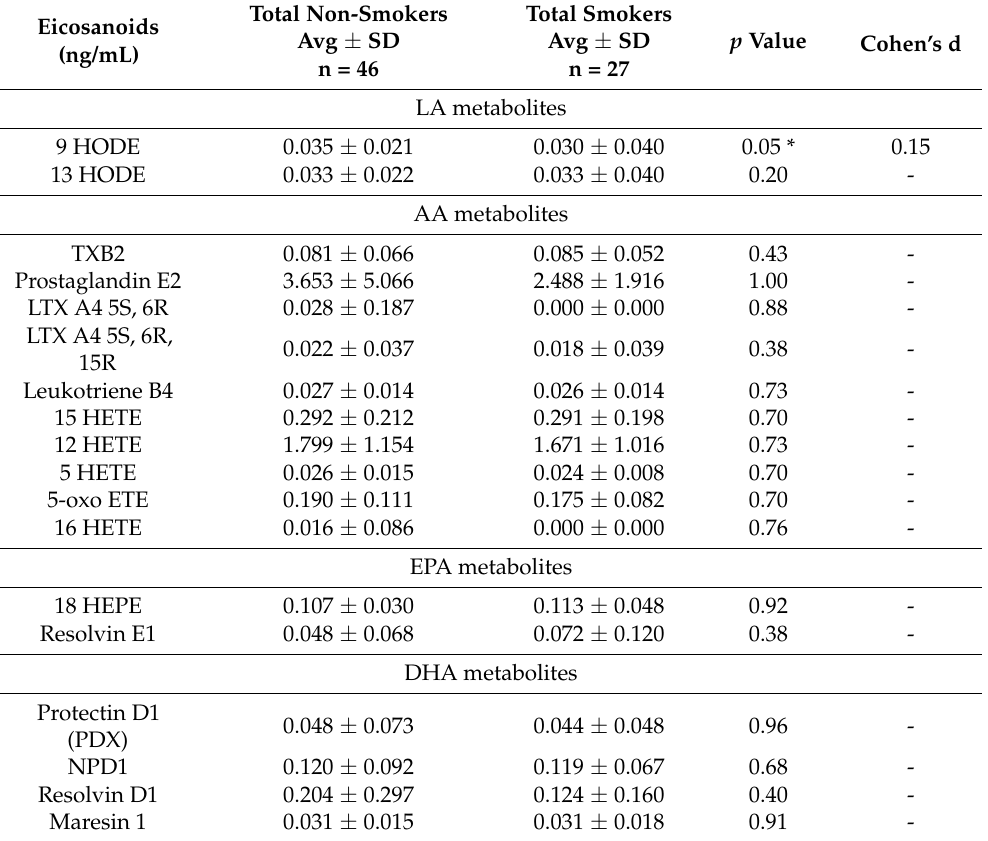
Table 1. Eicosanoid levels in groups of smokers and non-smokers, excluding gender.